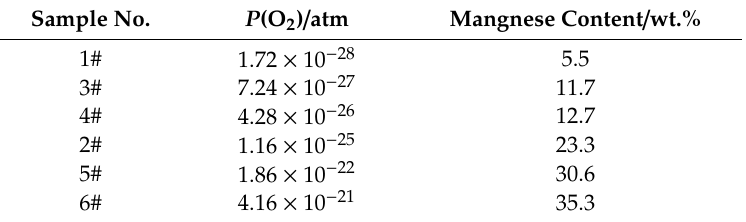
Table 3. EDS analyses results of manganese contents on the surfaces of 1#–6# samples. Sample No. P (O 2 ) / atm Mangnese Content /